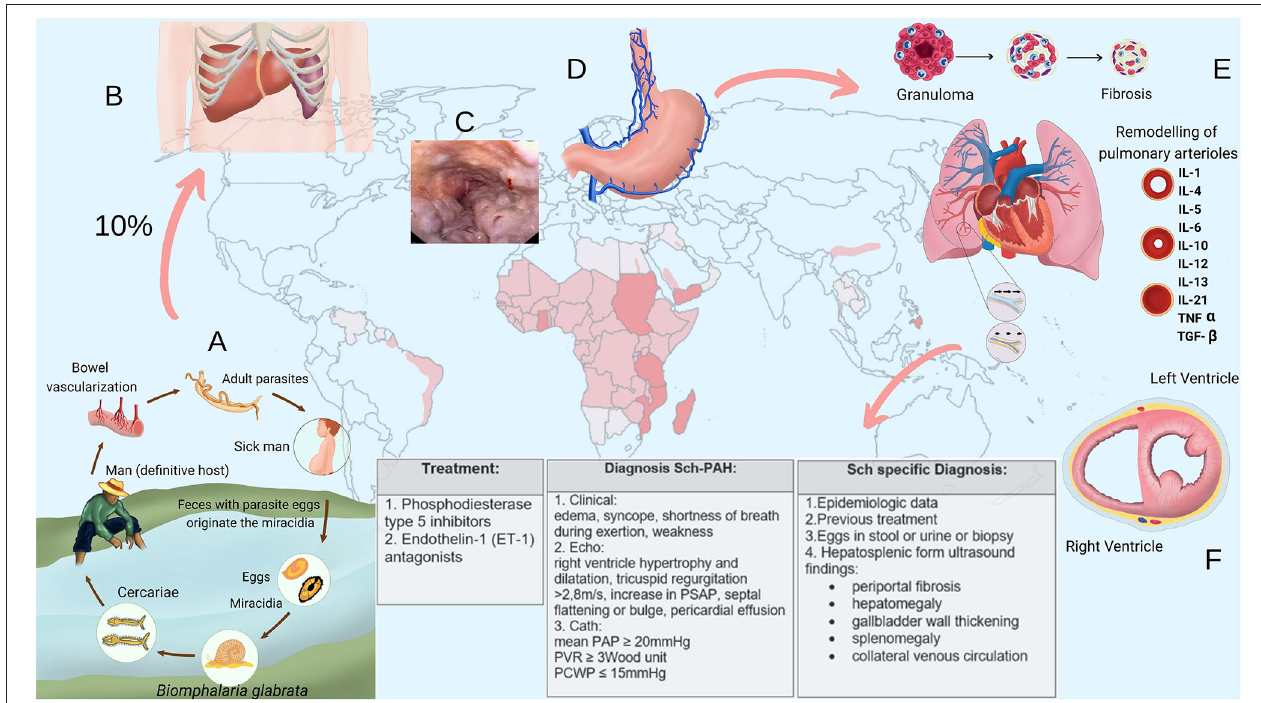
FIGURE 1 | (A) Schistosome life cycle. (B) Enlarged liver and spleen in hepatosplenic schistosomiasis. (C) Endoscopic aspect of esophageal varices. (D) Collateral venous circulation. (E) Pulmonary vascular remodeling in schistosome-associated pulmonary arterial hypertension. (F) Right-heart strain (cross section of the